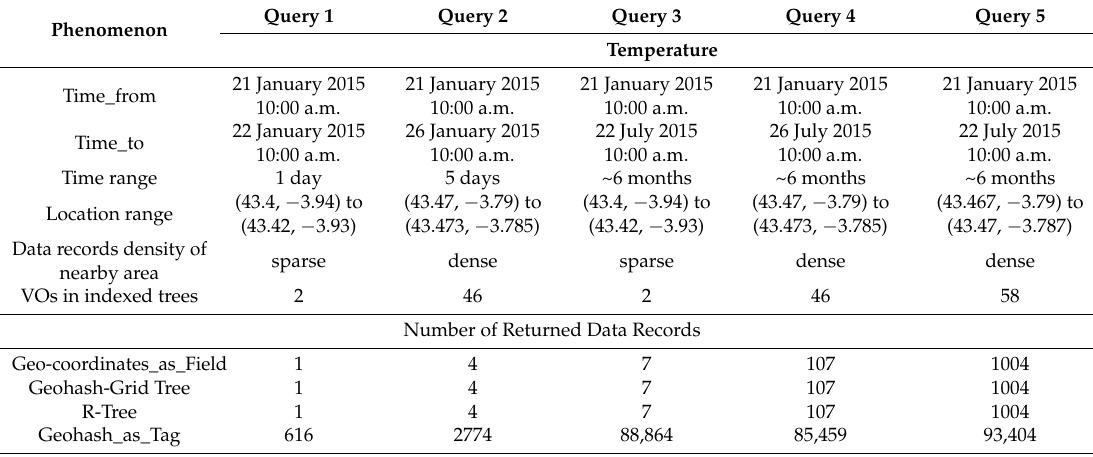
Table 7. Query Constraints and Number of Query